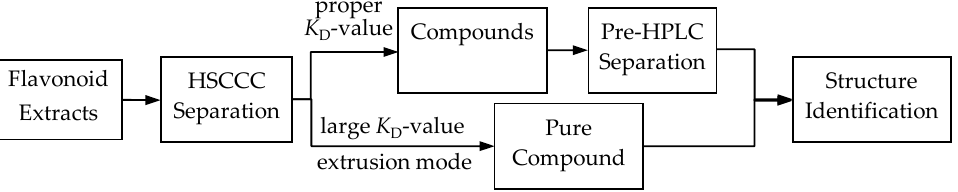
Figure 5. Diagram of the article procedure.